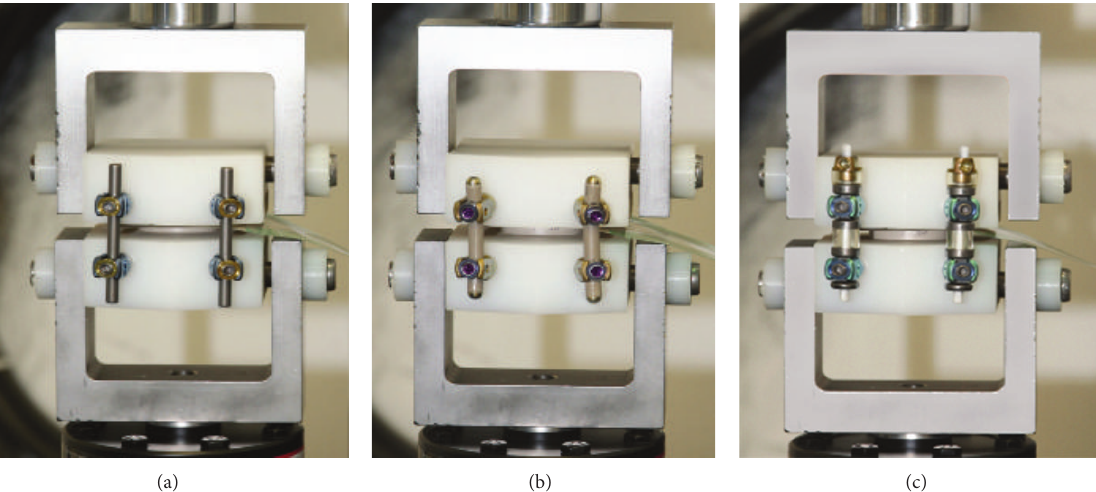
Figure 2: Testing constructs loaded in fixtures. Left to right: rigid rods, PEEK rods, and posterior dynamic stabilization. The pressure film can be seen above the spacer.